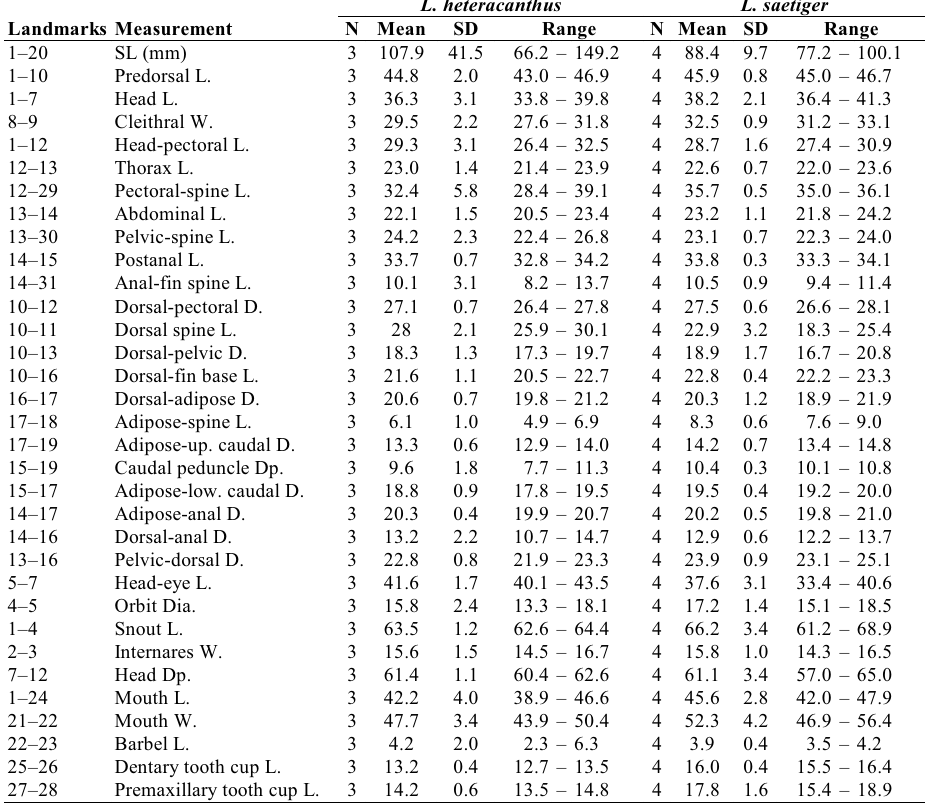
Table 2. Selected morphometrics of Lasiancistrus heteracanthus and L. saetiger . Ratios are percent of SL (Predorsal L. to Pelvic-dorsal D.) or percent of Head L. (Head-eye L. to Premaxillary tooth cup